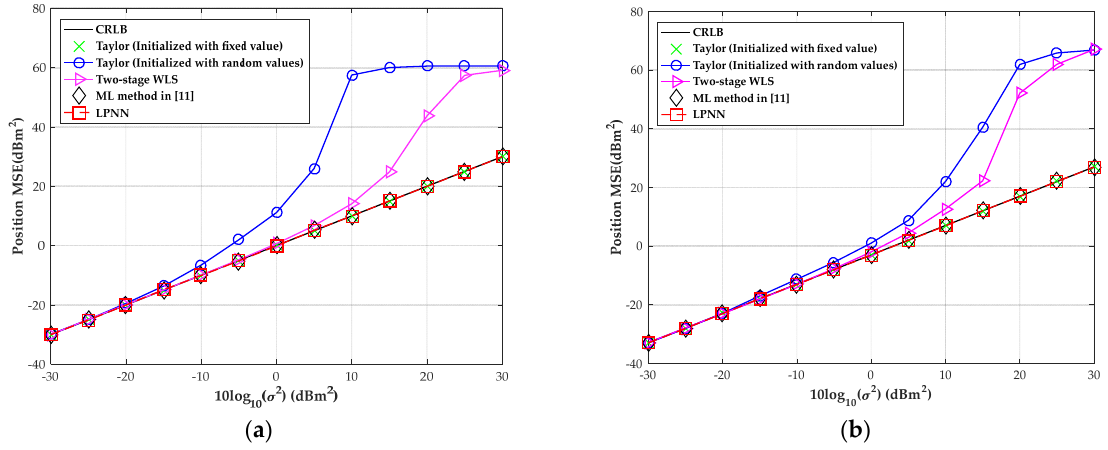
Figure 8. MSE versus level of measurement noise with the source position located at ( 300, − 280 ) m. ( a ) Four sensors; ( b ) eight sensors.